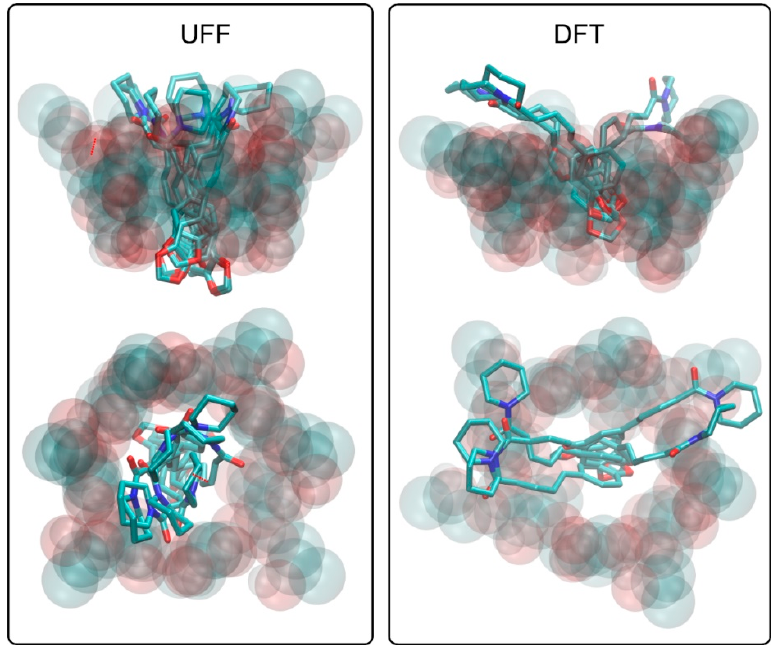
Figure 2. The piperine–HP- β -CD complexes obtained in the study: UFF-optimized structure of HP- β -CD ( left ) and density functional theory (DFT)-optimized structure of HP- β -CD ( right ). See the main text for details.